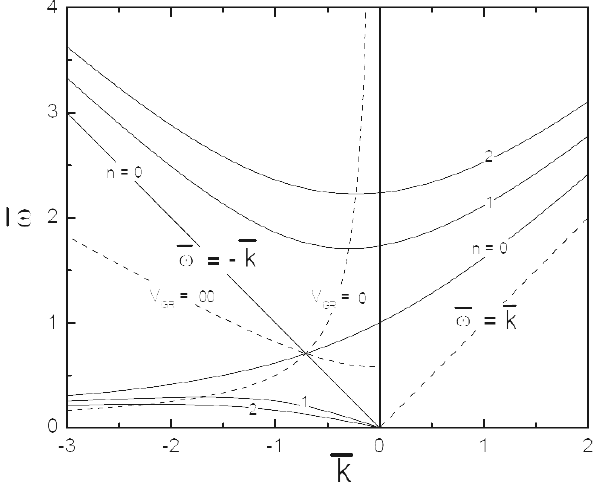
Fig. 1. The “mid-latitude”/JWKB dispersion ( ¯ ω, ¯ k ) curves for three values of the stability parameter m : m < 1 ( 0 . 5 ) stable, m = 1, marginally stable, m > 1 ( 1 . 5 ) unstable in the intermediate frequency-wave number band lying between the intersection of the ( ¯ ω, ¯ k ) curves and the locus of infinite group velocity V gr =∞ .